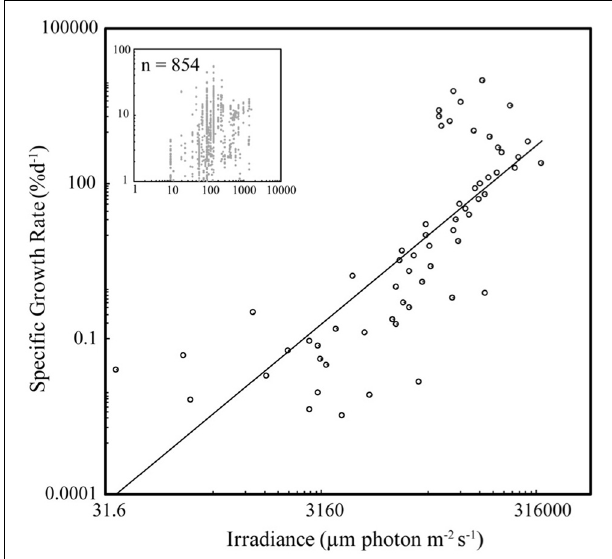
FIGURE 2 | The relationship between SGR and irradiance (I) for seaweed growing under experimental or culture conditions. The closed symbols show the mean values for BD bins of 0.1 g FW L − 1 , for BD < 1 g FW L − 1 , and intervals of 1 g FW L − 1 for greater values, and the insert shows the raw values. The fitted power law for the binned and raw data are SGR = 2.0 × 10 − 7 I 1 . 72 ± 0 . 18 ( R 2 = 0.60, F = 90.7, N = 61, P < 0.001) and SGR = 0.58 I − 0 . 41 ± 0 . 03 ( R 2 = 0.15, F = 143.8, N = 854, P < 0.001).